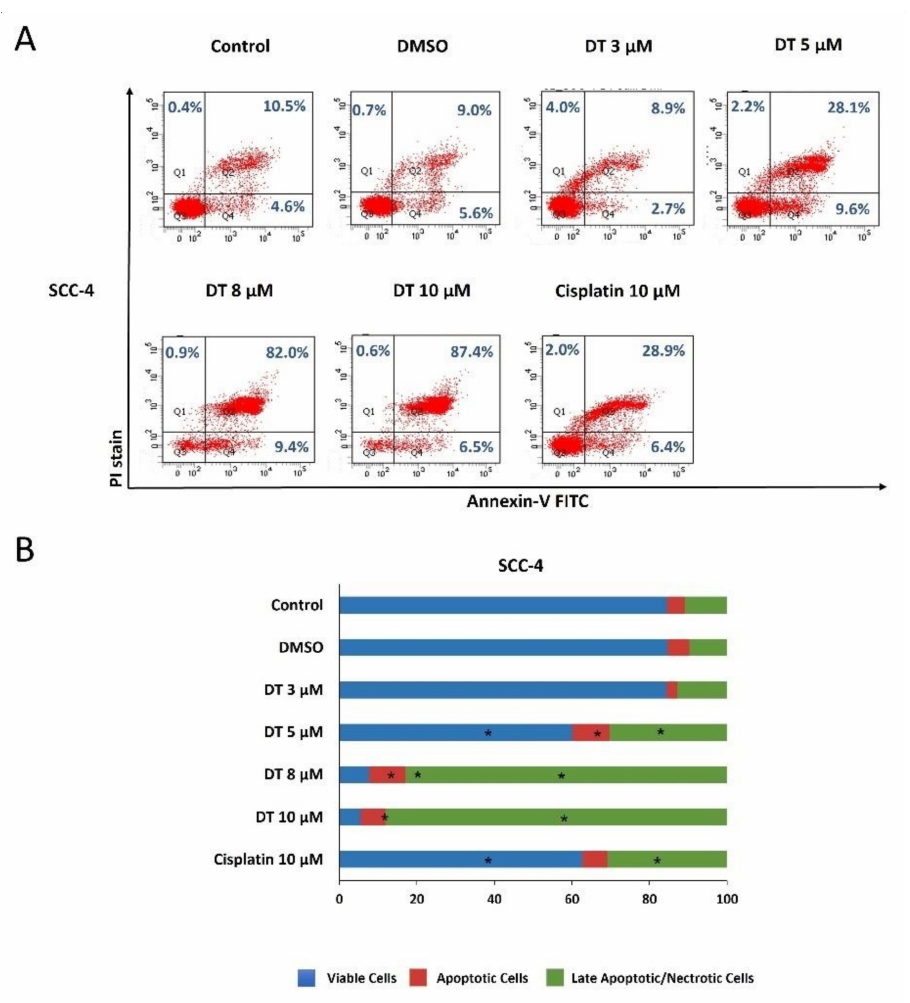
Figure 3. DT-induced apoptosis in SCC-4 cells. ( A ) SCC-4 cells were treated with DMSO or DT (3, 5, 8, and 10 µ M) for 24 h, and the percentages of viable cells (annexin V( − )/PI( − )), apoptotic cells (annexin V(+)/PI( − ), and late apoptotic/necrotic cells (annexin V( − )/PI(+) and annexin V(+)/PI(+)) were determined through annexin V/PI staining followed by flow cytometric analysis. ( B ) The distribution of viable, apoptotic, and late apoptotic/necrotic cells after DT treatment was calculated from the means from three independent experiments. * indicates a statistically significant difference compared with untreated control